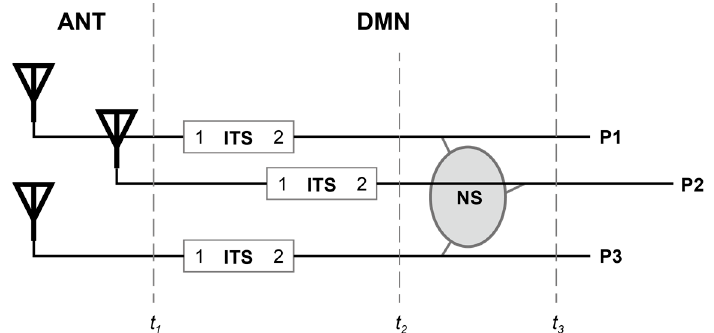
Figure 1. The DMN of a three-element circular array.